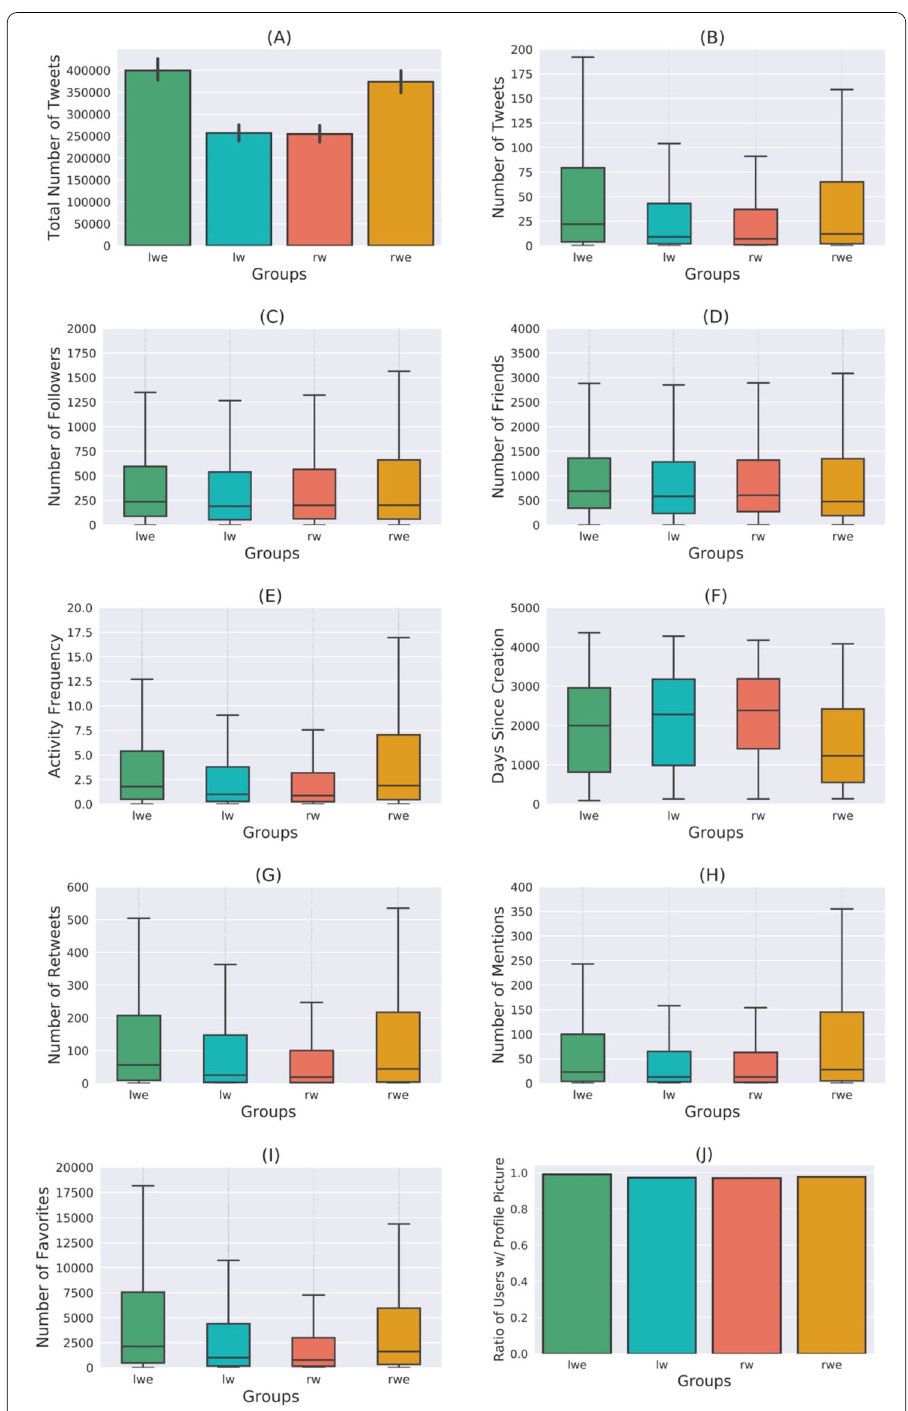
Figure A1 Distribution of the covariates listed in Table 5 (except for topics) across different political